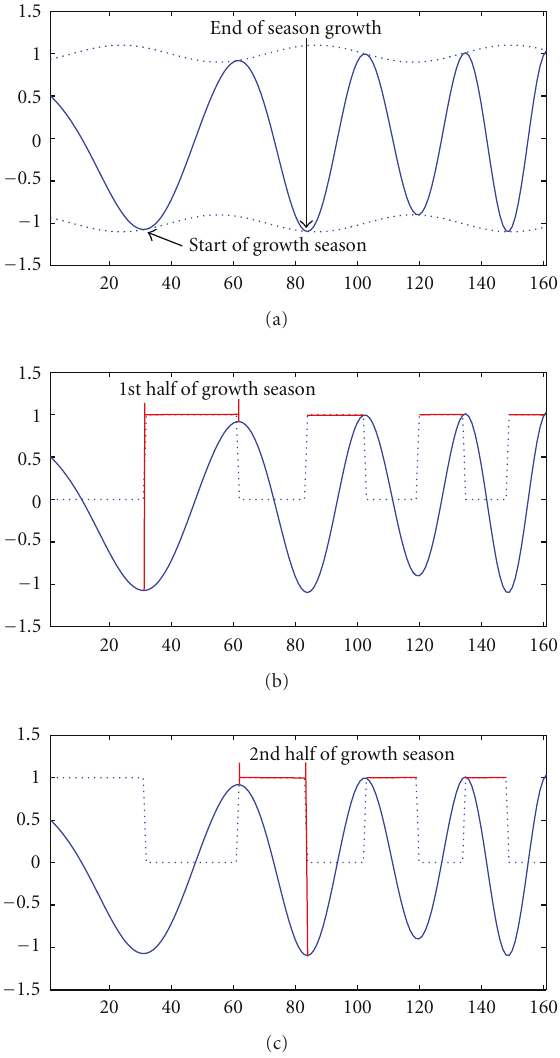
Figure 3: Phase modulation model along radial direction. (a) AM- FM signal for modeling growth. (b) First half period growth model based on phase values: π ≤ φ < 2 π . Phase values that satisfy this condition are plotted with a dotted line. (c) Second half period growth model based on 0 ≤ φ < π